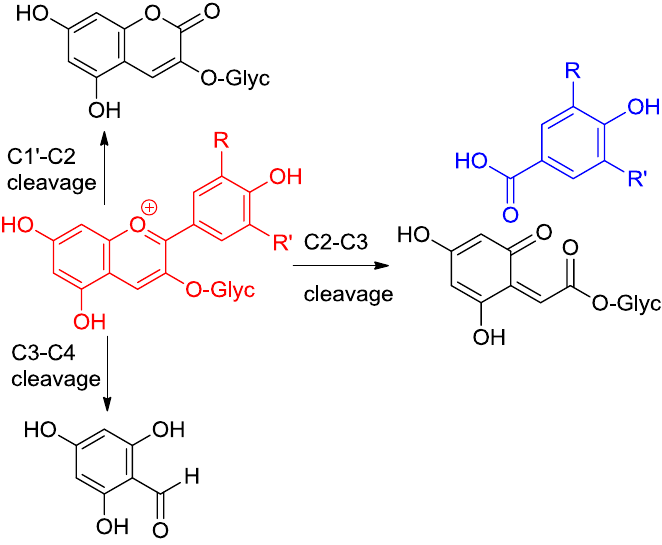
Figure 8. Pathways of anthocyanin degradation. Molecules 2018 , 23 , x